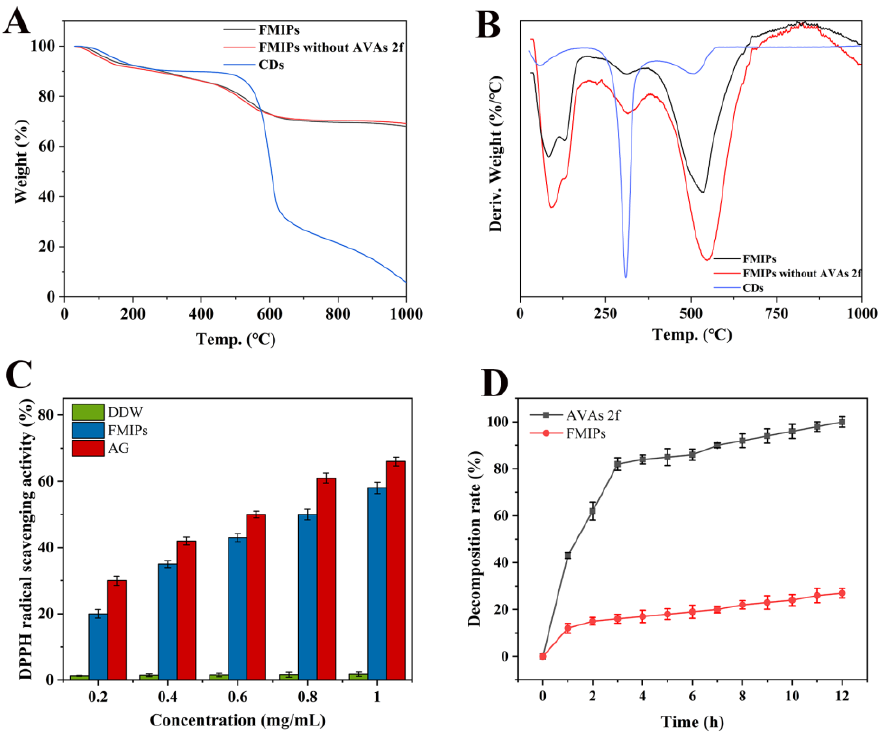
Figure 3. ( A ) TGA and ( B ) DTG curves of FMIPs, FMIPs without AVAs 2f, and CDs, ( C ) DPPH- scavenging activity of FMIPs, ( D ) Degradation rates of AVAs 2f and FMIPs under ultraviolet irra- diation.